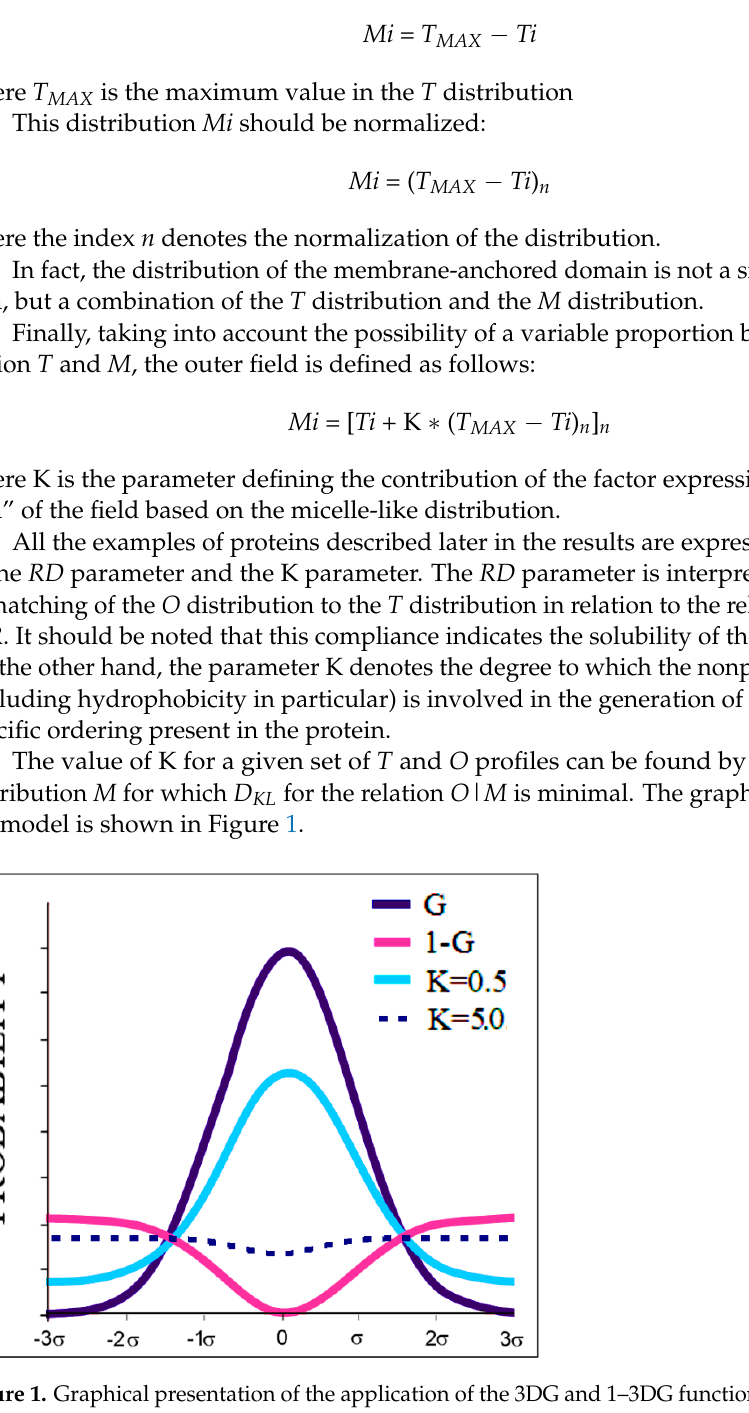
Figure 1. Graphical presentation of the application of the 3DG and 1–3DG functions and the influence of the parameter K = 0.5. The dotted line represents the characteristics of a membrane protein (K = 5.0). The values of K are included only for presentation in a very simplified form. All plots are shown after normalization.